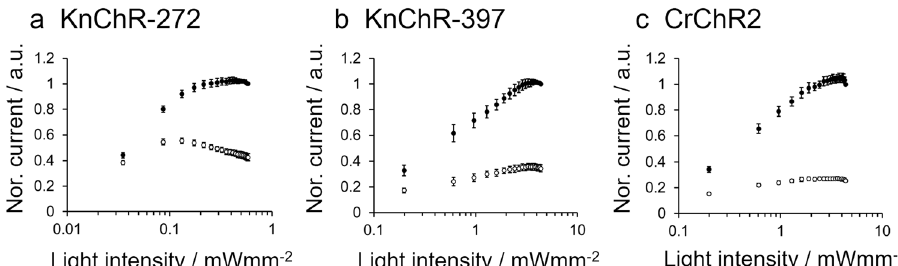
Fig. 5 Light intensity dependence of KnChR-272, KnChR-397, and CrChR2. The photocurrent was measured with various intensities of 480 nm light. a KnChR-272, b KnChR-397 and c CrChR2. Membrane voltage was clamped at − 60 mV. Standard solutions were used (See “ Methods ” ). Black circle, peak current; empty circle, steady-state current. Data were presented as the mean ± SEM. N = 6 ( a ), 4 ( b ), and 6 ( c ).